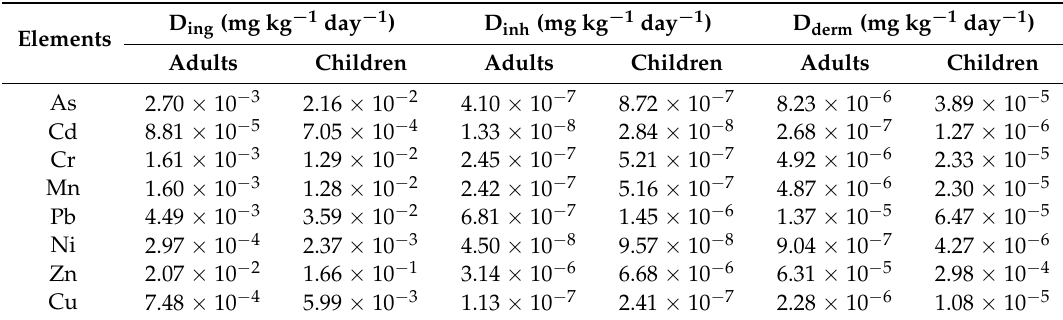
Table 4. Average daily dose of each element from different exposure pathways: D ing , ingestion; D inh ,